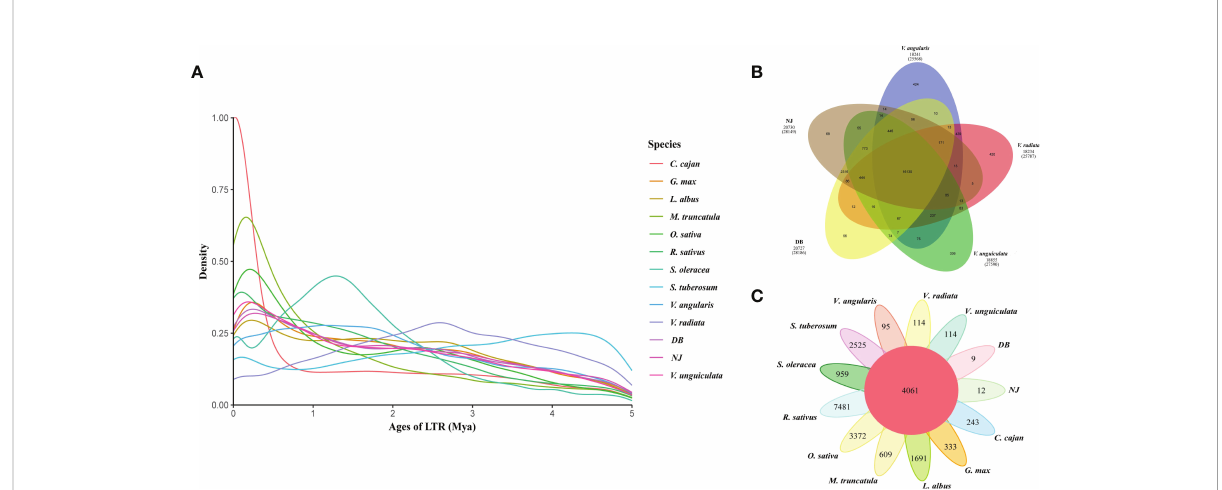
FIGURE 2 Number of orthogroups containing species and the LTR insertion time. (A) . LTR insertion time. The formula for calculating time is T = K/(2 × r), where the molecular clock r is chosen as 7×10 -9 . (B) . Venn diagram represents shared and unique gene families of fi ve legumes (NJ, DB, V. unguiculata , V. angularis , and V. radiata ). (C) . Petal map of shared and unique gene families across 13